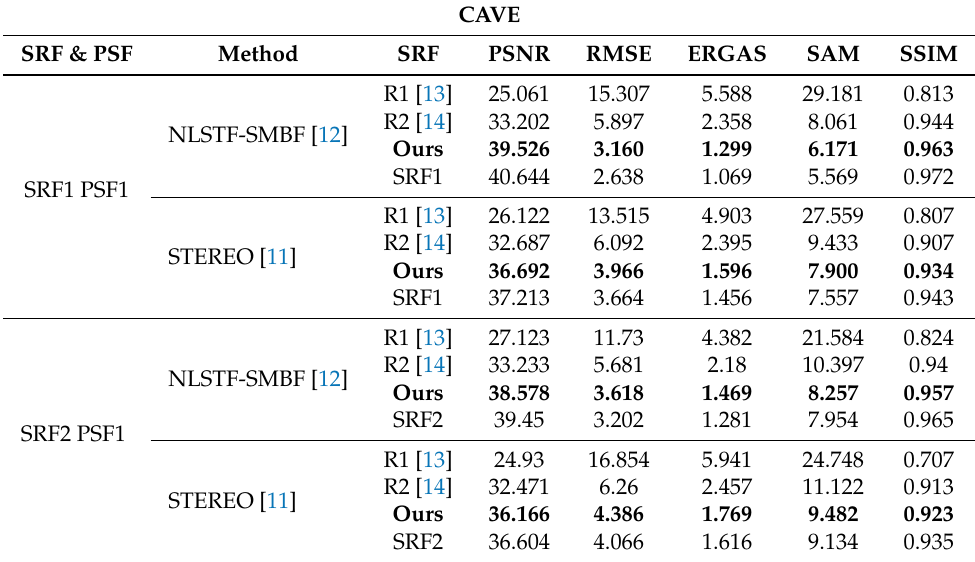
Table 3. Fusion results of objective metrics after two semi-blind methods using different SRFs on the CAVE